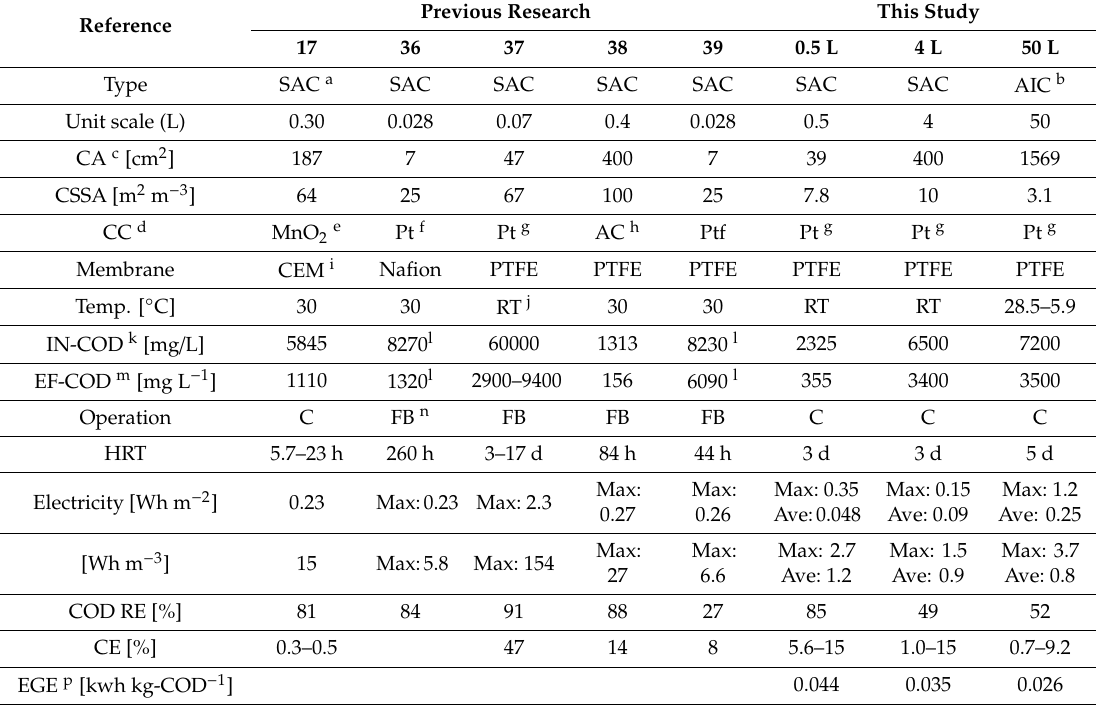
Table 1. A comparison of microbial fuel cell (MFC) performance for treating swine wastewater.